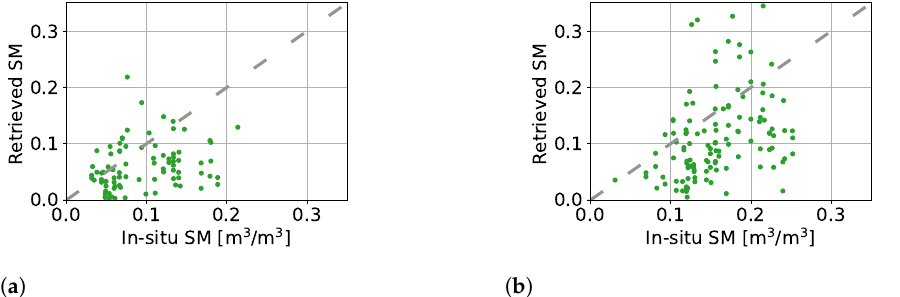
Figure 16. Soil moisture retrieval using the first scheme from DDMs close to Y8 compared to the averaged in situ soil moisture of Y5, Y7, and Y8 stations. ( a ) Year 2019. ( b ) Year